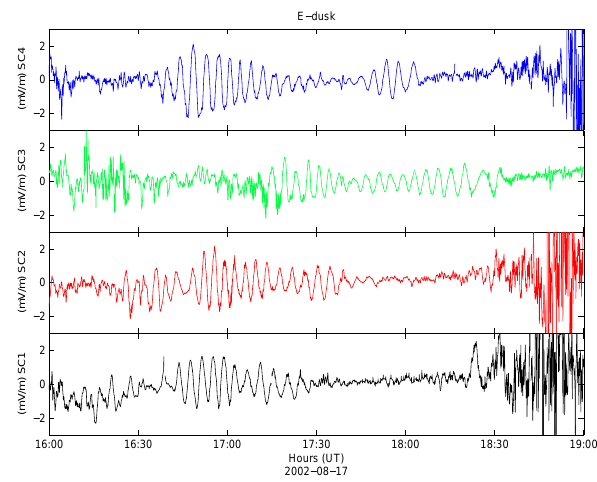
Fig. 3. The duskward electric field for the 17 August 2002 event. The bottom panel is s/c 1 (black), followed by s/c 2 (red), s/c 3 (green) and s/c 4 (blue) at the top.